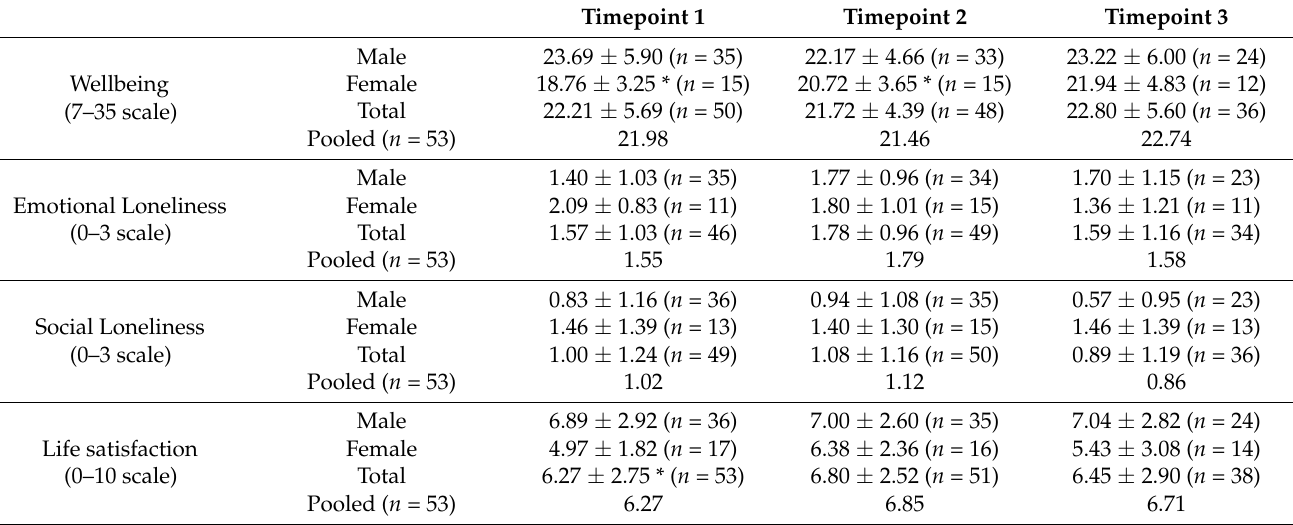
Table 2. Mean ± SD raw data and pooled mean data for outcome